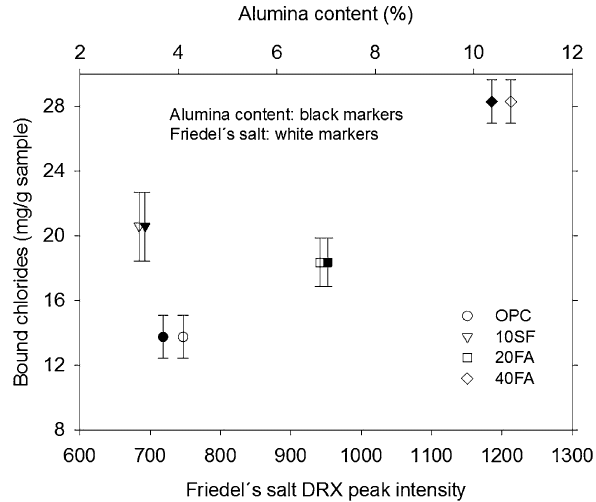
Fig. 5 Percentage of Al 2 O 3 present in each paste and the Friedel’s salt maximum intensity peak from XRD, versus the bound chlorides in cement